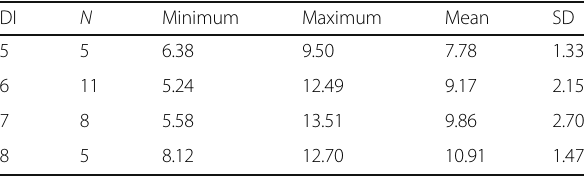
Table 6 Descriptive data for mean RID0 (baseline) according to